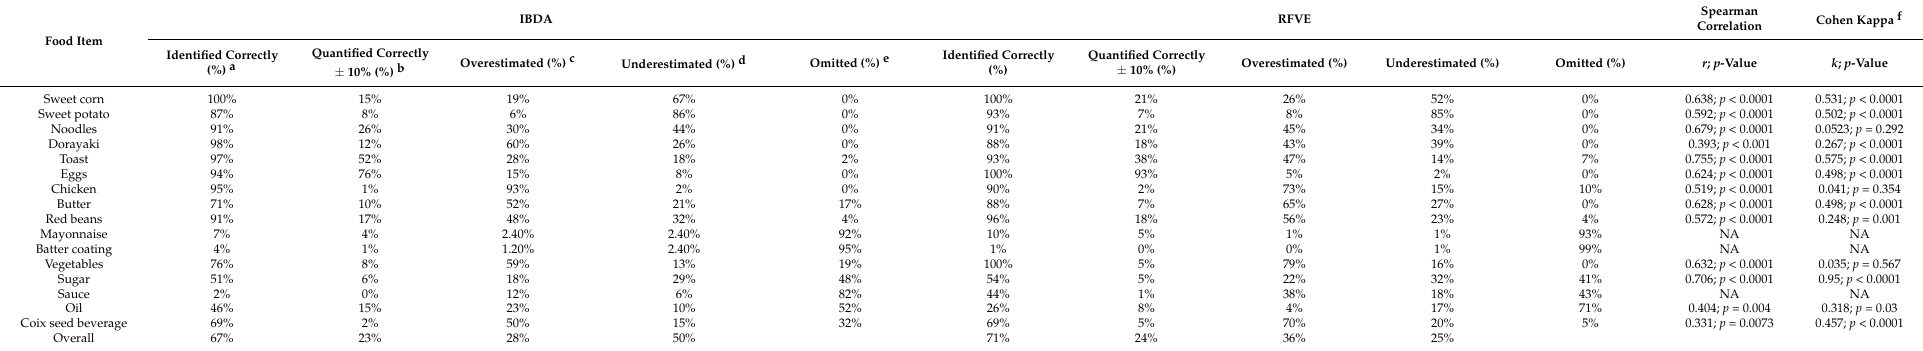
Table 1. Accuracy in food identification and portion size quantification in image-based dietary assessments (IBDAs) and real food visual estimations (RFVEs) evaluated in the first semester of the nutrition practicum course ( n =